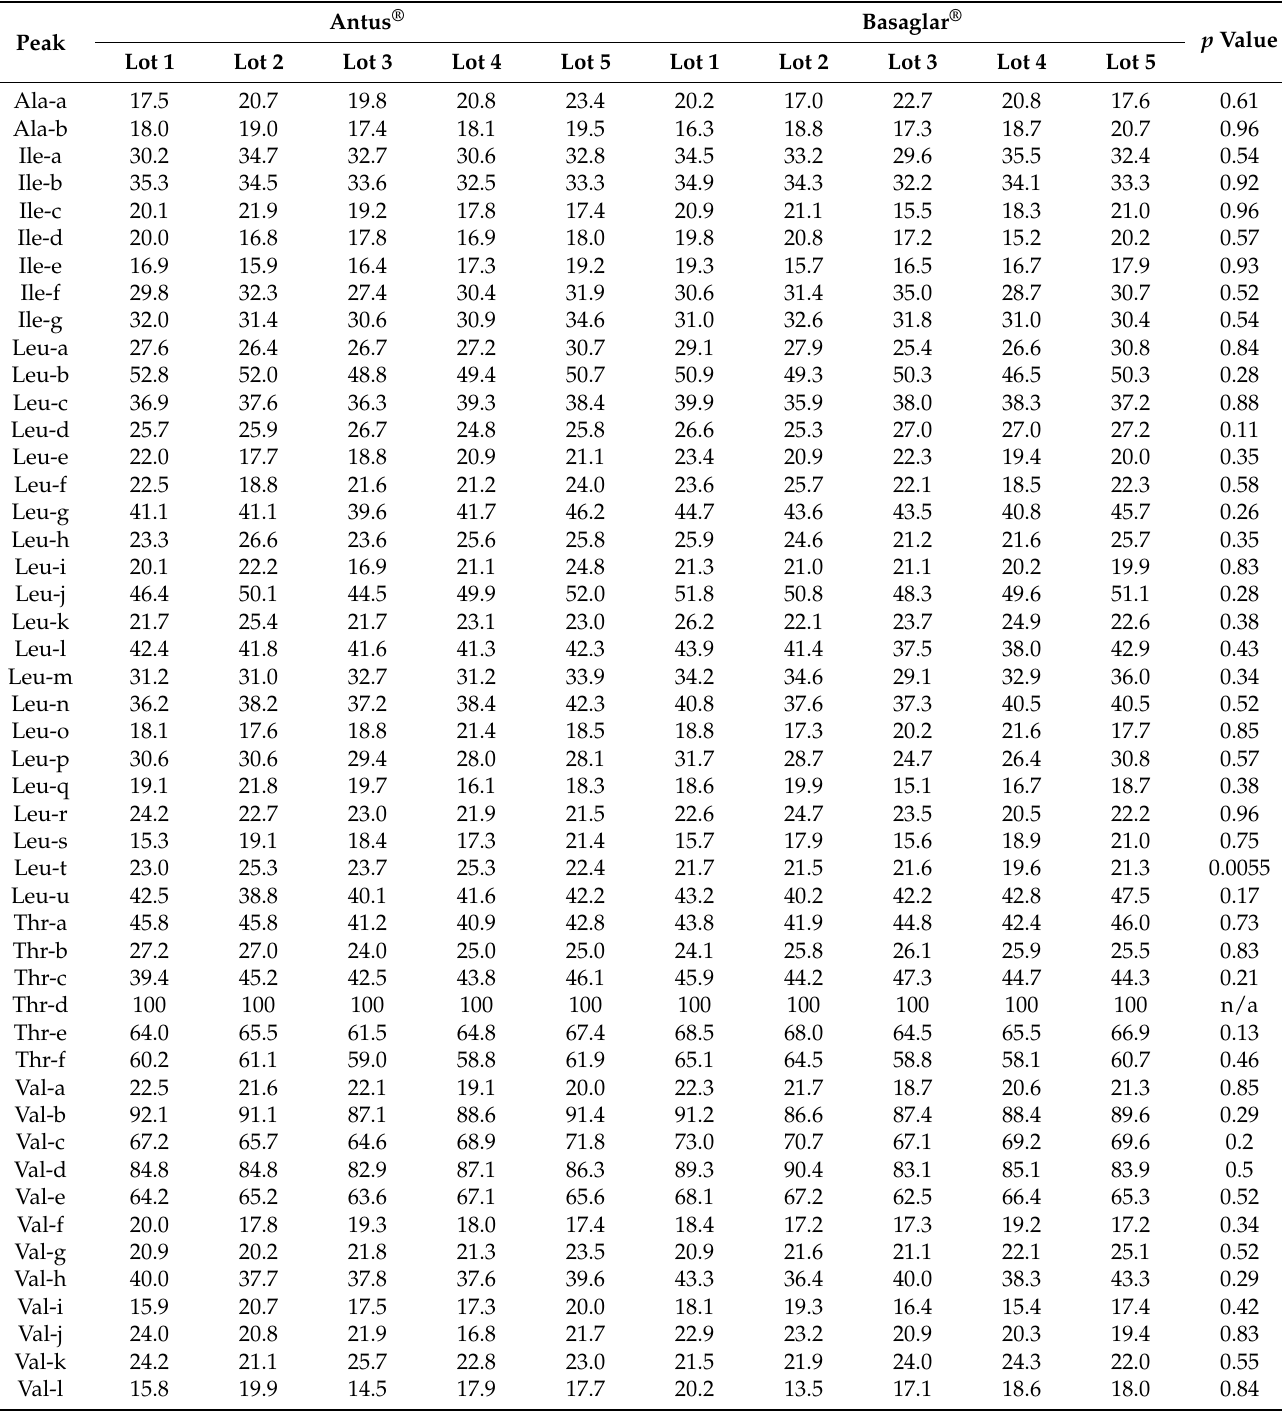
Table 2. The relative peak height comparison of insulin glargine